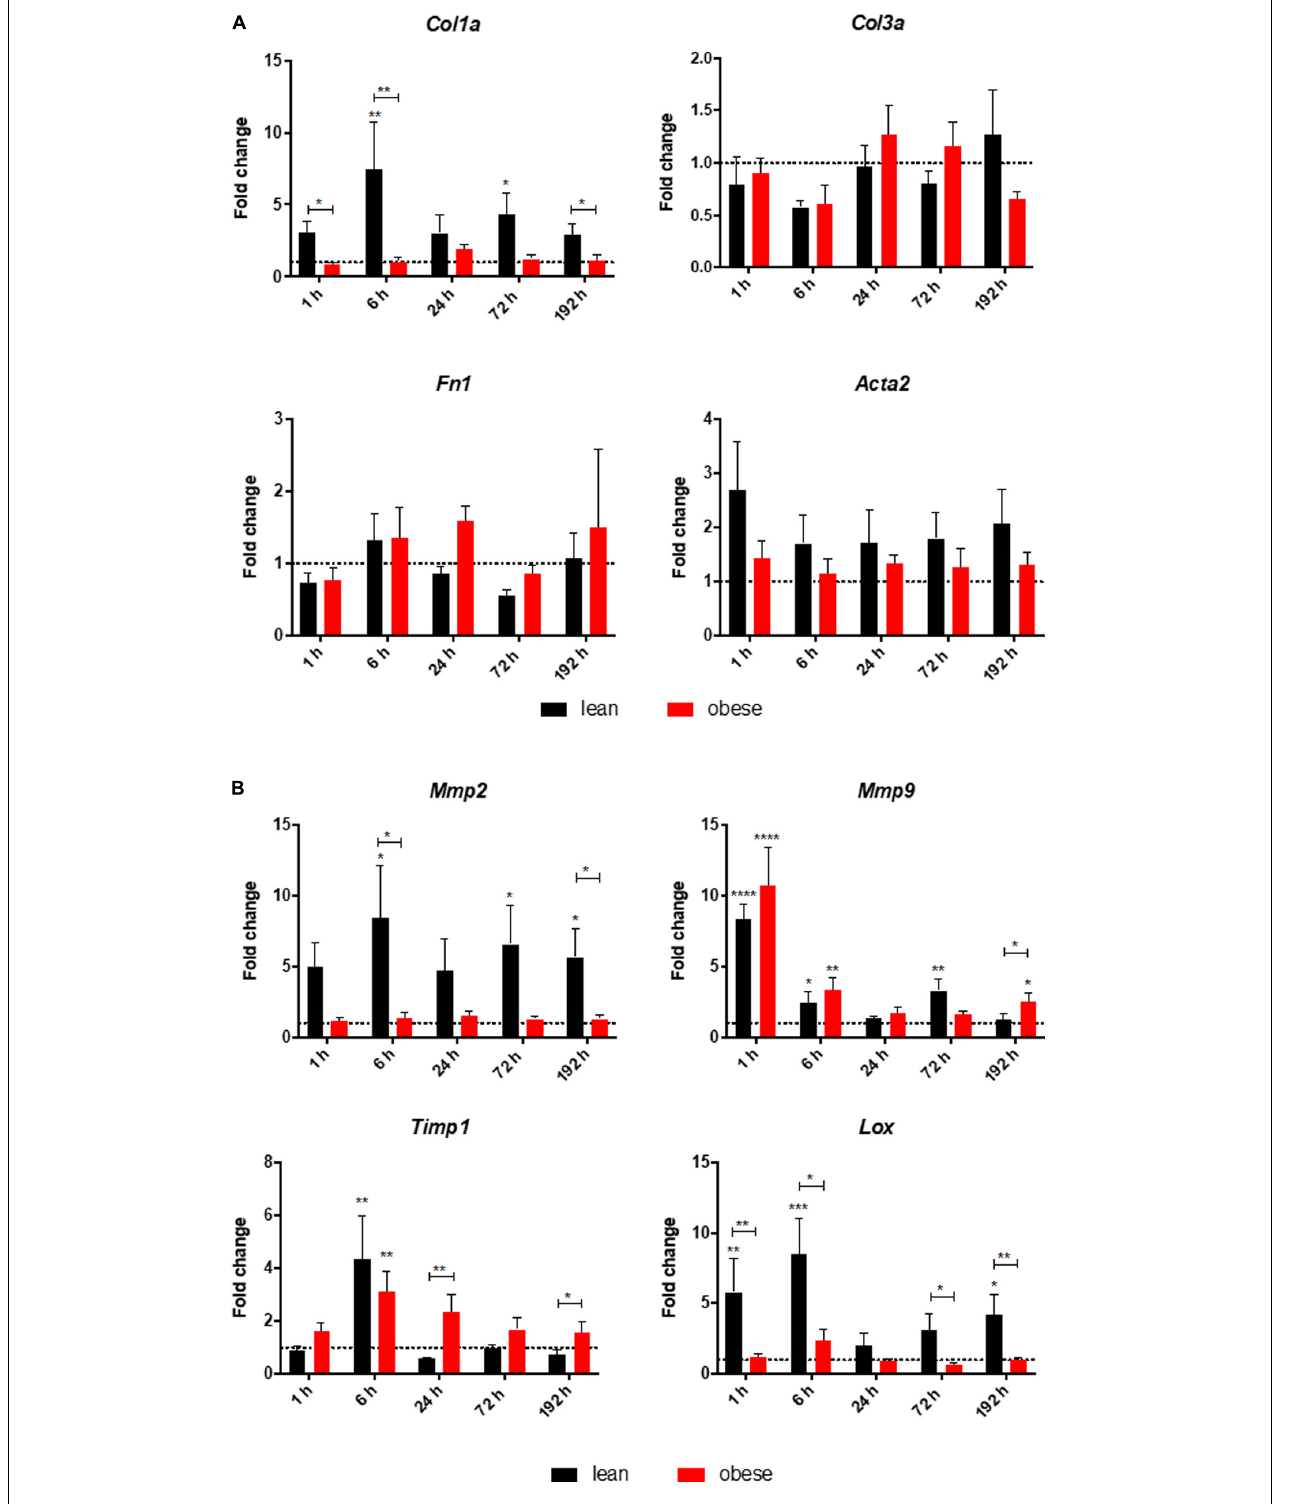
FIGURE 3 | Altered response in obese mice to the trauma based on gene expression profiles of (A) ECM structure genes Col1a , Col3a, and Fn1 as well as Acta2 and (B) ECM organizing genes namely Mmp2 , Mmp9 , Timp1, and Lox in the lung. Statistical significance was determined using two-way ANOVA followed by an uncorrected Fisher’s LSD test ( α = 0.05). * p < 0.05, ** p < 0.01, *** p < 0.001, **** p < 0.0001. Indicators of significance directly above the bars of the diagram indicate a statistical difference to the control, while starts above the connector line show differences between the two diets at that specific time point.